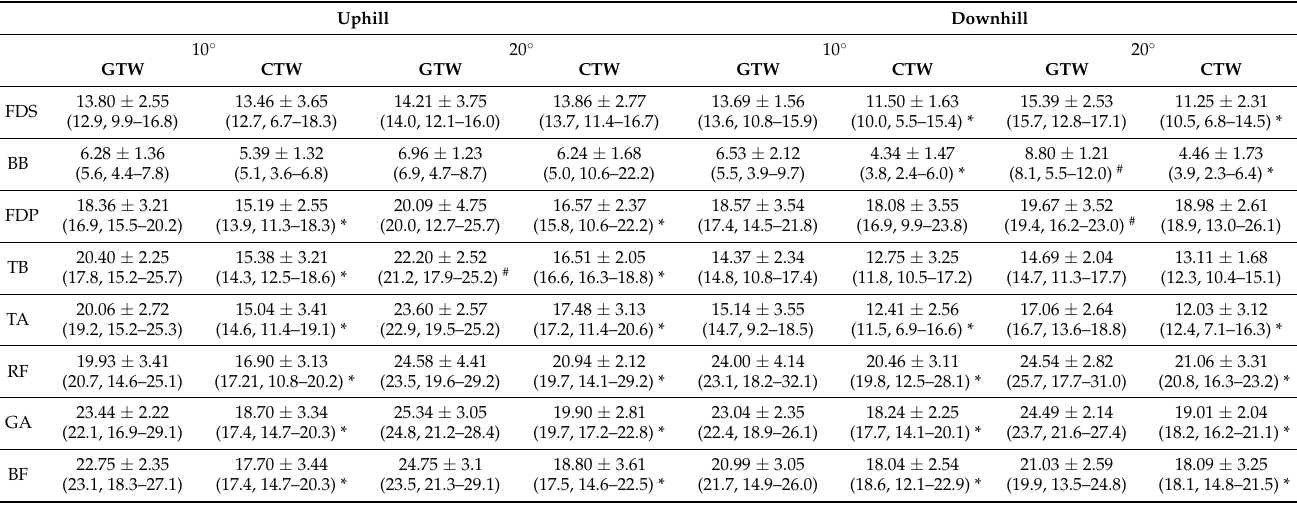
Table 6. Upper and lower extremity muscle activity in sloped terrain.